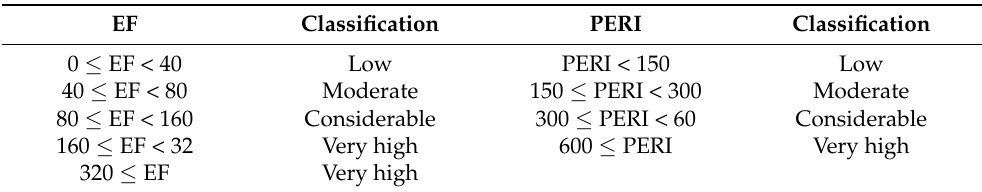
Table 1. Monomial potential ecological risk factor (EF) and potential ecological risk index (PERI) classification levels